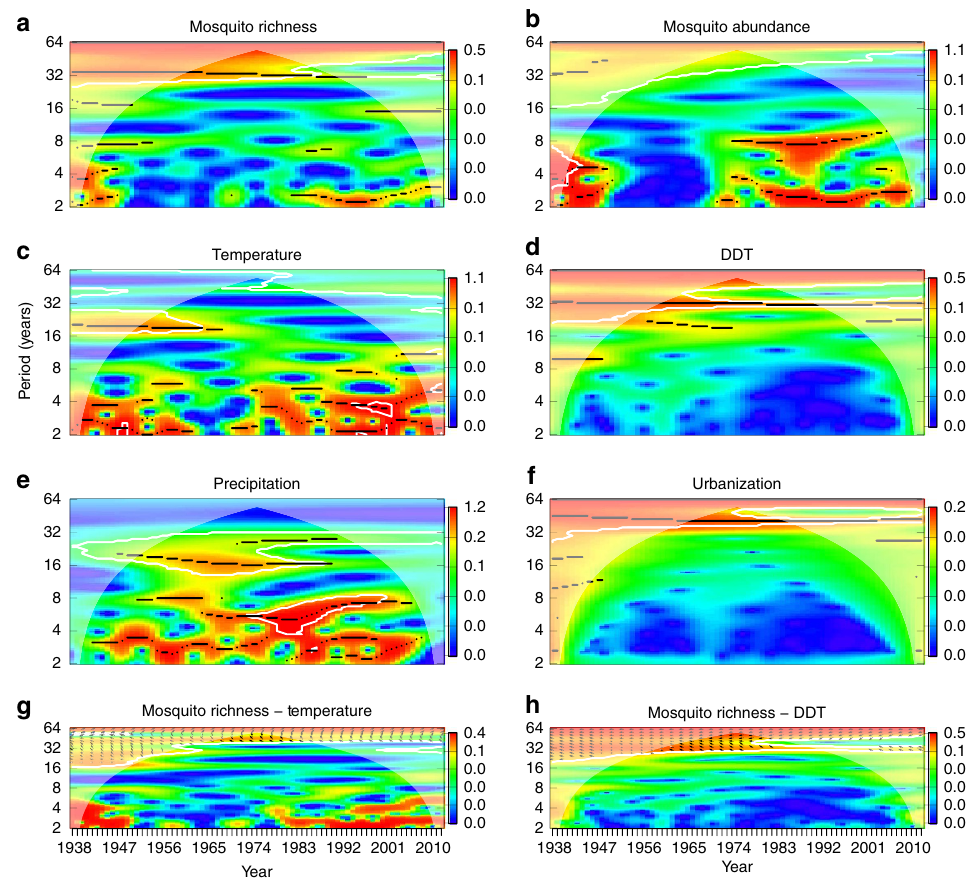
Figure 3 | Wavelet analysis of time series. ( a – f ) The power level of each time series (mosquito species richness ( a ), mosquito abundance ( b ), temperature ( c ), DDT ( d ), precipitation ( e ) and urbanization ( f )) from New York using a Morelet wavelet at each Fourier period or frequency ( y axis in years) over the length of the time series ( x axis) with warmer colours indicating higher power levels (right legends). Black lines indicate power ridges. The whitish cone indicates parts of the analysis influenced by edge-effects. The bottom two panels show the cross-wavelet coherence spectrum for two pairs of time series (( g ) mosquito richness—DDT and ( h ) mosquito richness—temperature), with white outlines surrounding significant coherence correlations ( P o 0.1) and arrows indicating phase differences (arrows to the right indicate in-phase). The bottom two panels indicate moderate (higher periods) or non-significant (lower periods early and late in the time series) coherence between mosquito richness and temperature across most frequencies and parts of the time series and strong coherence between DDT concentration and mosquito richness across most of the time series at frequencies of 32 and 64